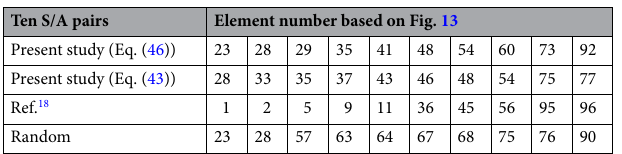
Ten S/A pairs Element number based on Fig.